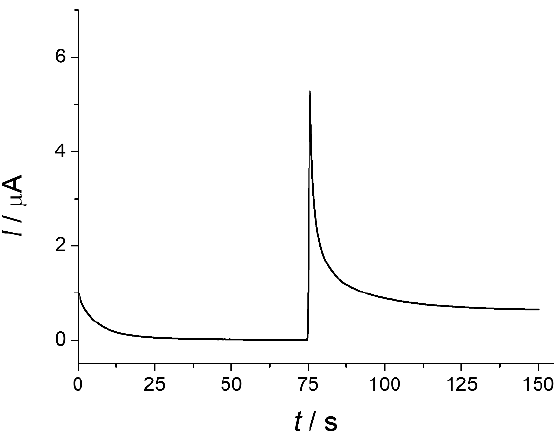
Figure 1. Typical view of the background subtracted chronoamperogram on an example of 10 μL of 10-fold diluted rosemary essential oil. E 1 = 0.8 V, E 2 = 1.4 V.